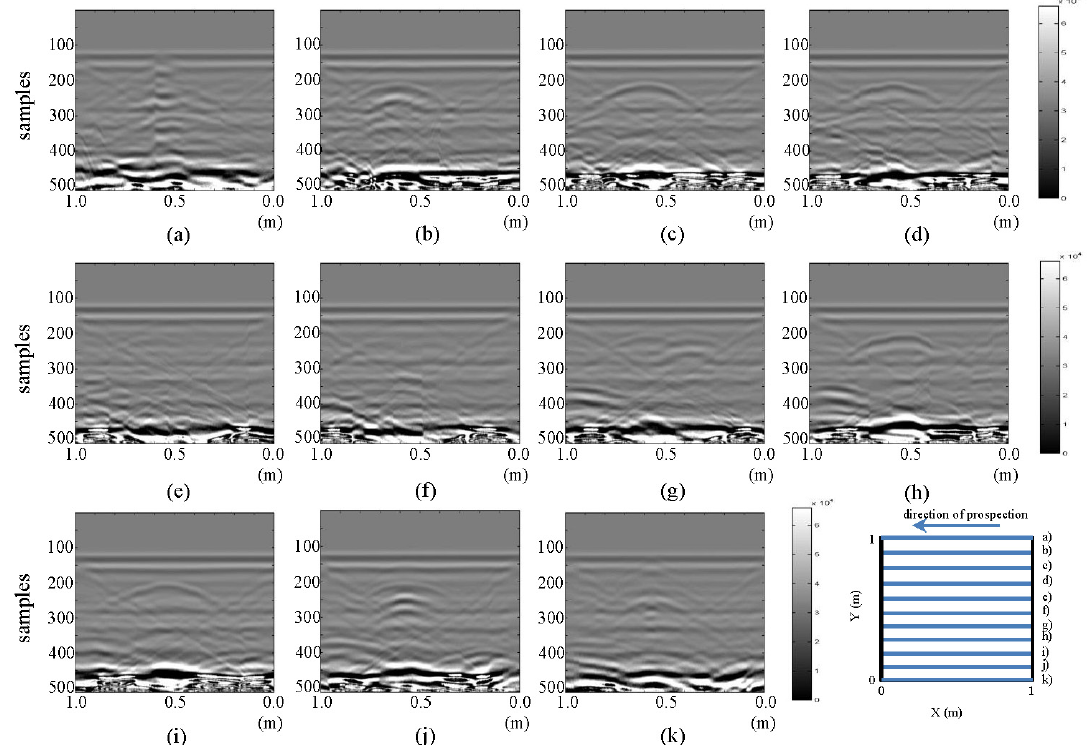
Figure 5. Horizontal profiles: raw images for final state: ( a – k ) are profiles s1 to s11, respectively.